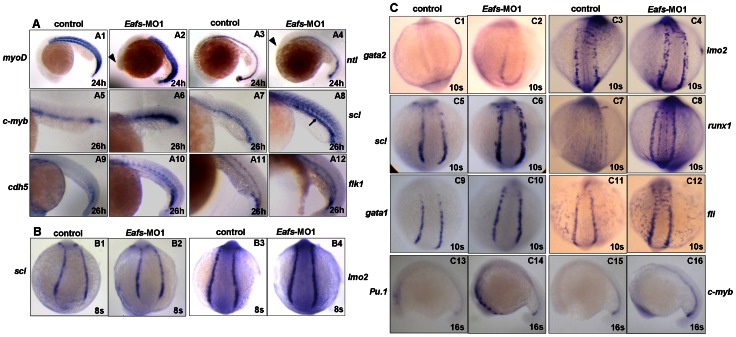
Erythroid defects in eafs morphants are specific.(A) At 24 hpf to 26 hpf, the expression detection of control or eafs-MO injected embryos (8 ng per embryo) processed by WISH for tissue specific genes: somites (A1, A2), notochord (A3, A4), vasculature (cdh5: A9, A10; flk1: A11, A12), and primitive progenitors (c-myb: A5, A6; scl: A7, A8, indicated by black arrow). (B) At the 8 somites stage, primitive hematoposis in eafs morphants, indicated by primitive progenitor genes (scl: B1, B2; lmo2: B3, B4). (C) At the 10 somites stage, progenitors for blood (gata2: C1, C2; lmo2: C3, C4; runx1: C7, C8; c-myb: C15, C16), progenitors for vasculature (fli: C11, C12), progenitors for both blood and vasculature (scl: C5, C6), more mature erythroid progenitors (gata1: C9, C10), and more mature myeloid progenitors (Pu.1: C13, C14). A1–A12, C13–C16, lateral view, anterior to the left. B1–B4, C1–C12, dorsal view, anterior to the up.